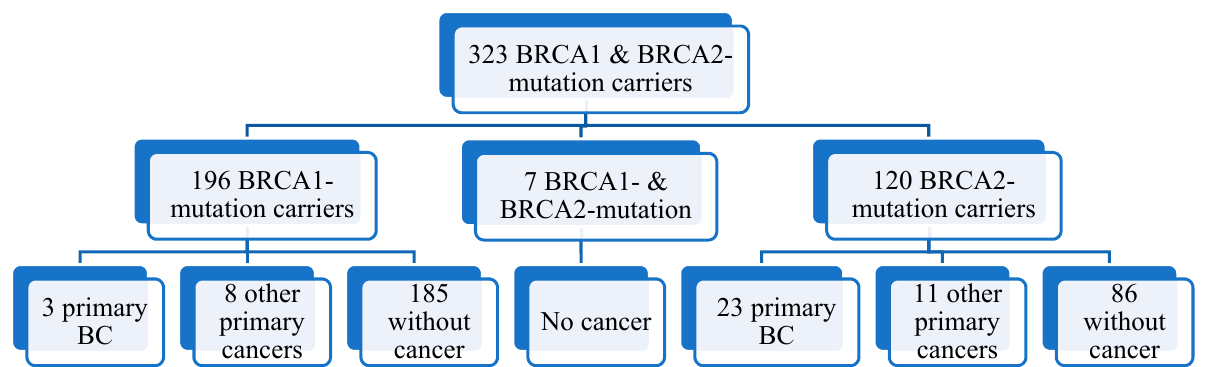
Figure 1. Cohort selection and